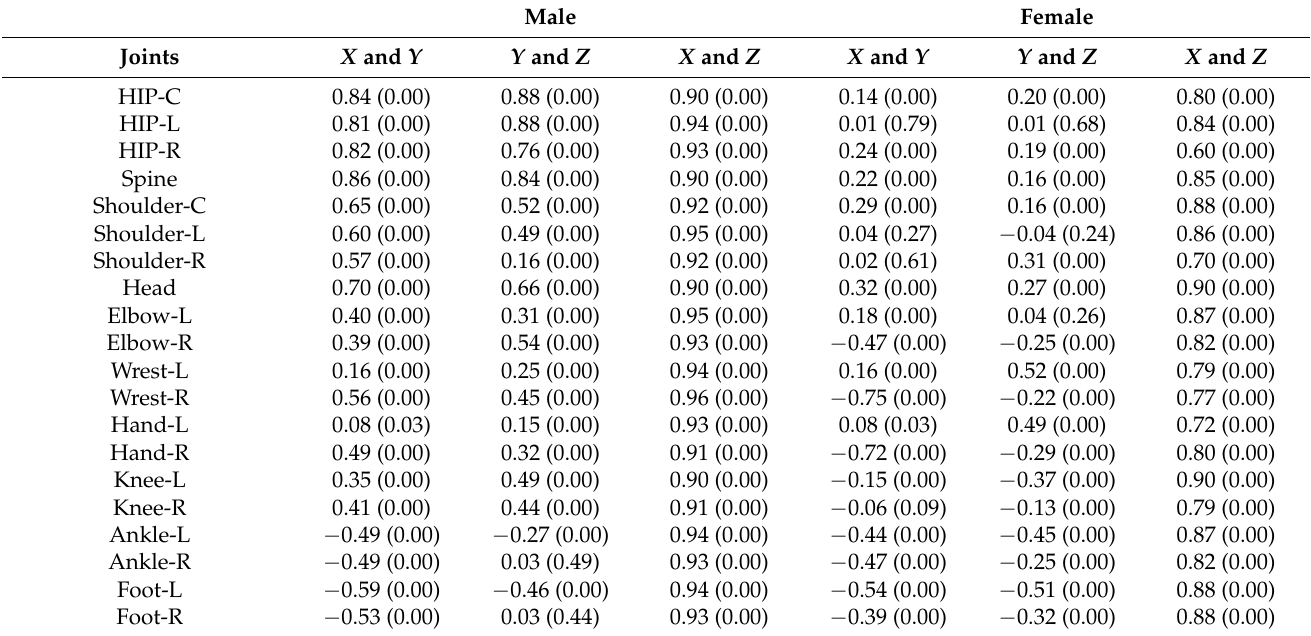
Table 2. The Pearson correlation between various joints in 3D coordinates system ( x , y , and z ). Male